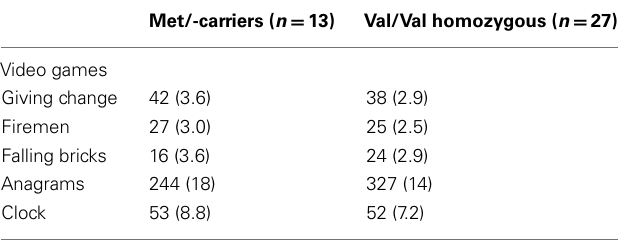
Table 2 | Mean video games of cognitive intervention scores for Met/-carriers andVal/Val homozygous